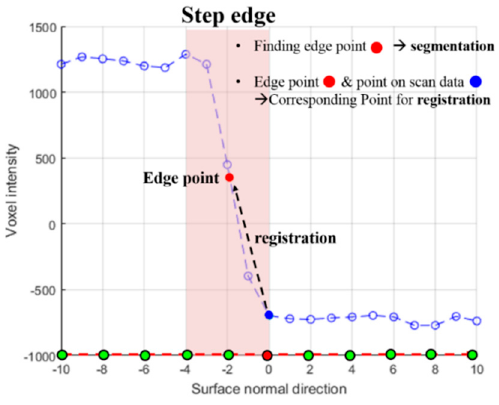
Figure 2. Intensity profile and step edge point.